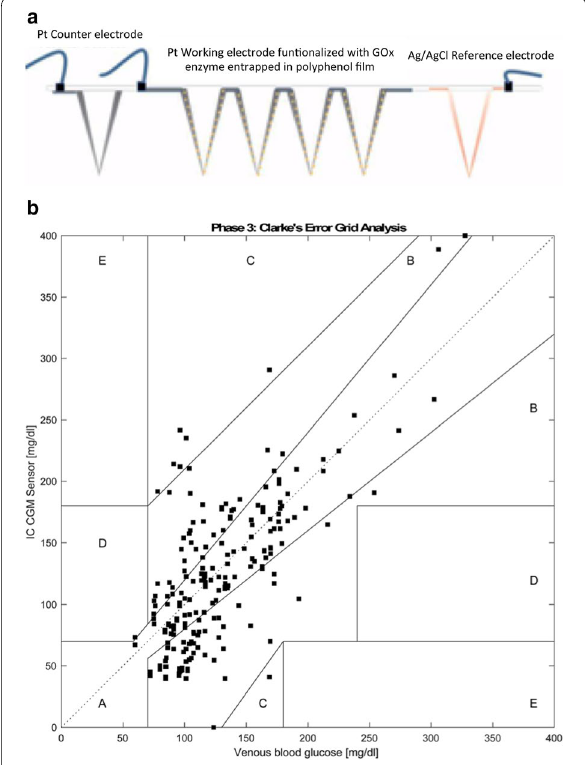
Fig. 1 a Schematic of the coated MN-based electrodes, b Measurement of Clarke error in the 24 h clinical test of the glucose monitoring system with the MN array (Reproduced with